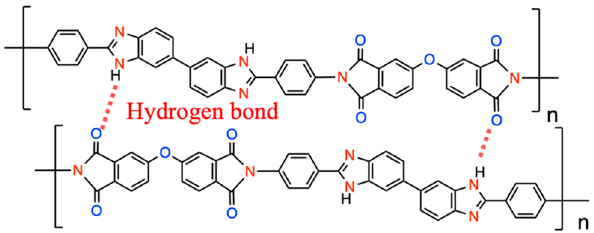
Figure 4. Schematic diagram of intermolecular H-bonding of BI-PI.